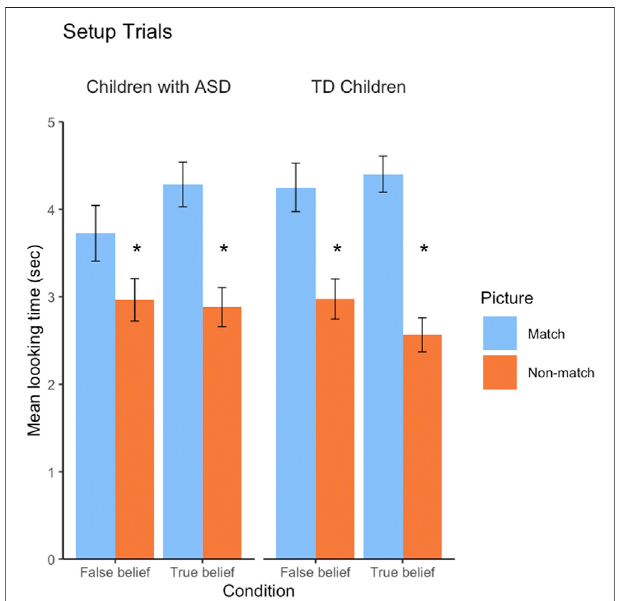
FIGURE 1 | Children ’ s mean looking times (in seconds) to the matching andnon-matchingpicturesaveragedacrossthe fi vesetuptrials,separatelyby condition and group. Error bars represent standard errors and asterisks indicateasigni fi cantdifferenceinlookingtimetothetwopictureswithina condition ( p < 0.05).